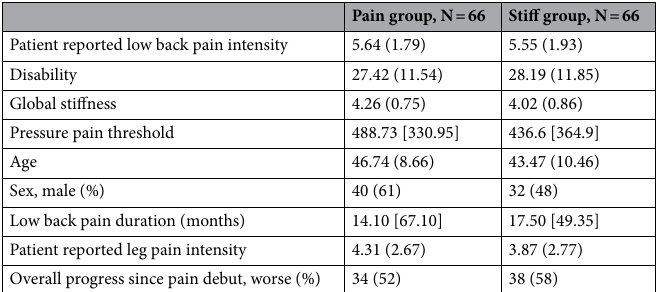
Table 2. An overview of baseline characteristics for participants with persistent low back pain who entered a randomized experimental trial. Presented as mean (standard deviation), median [interquartile range] or categorical.